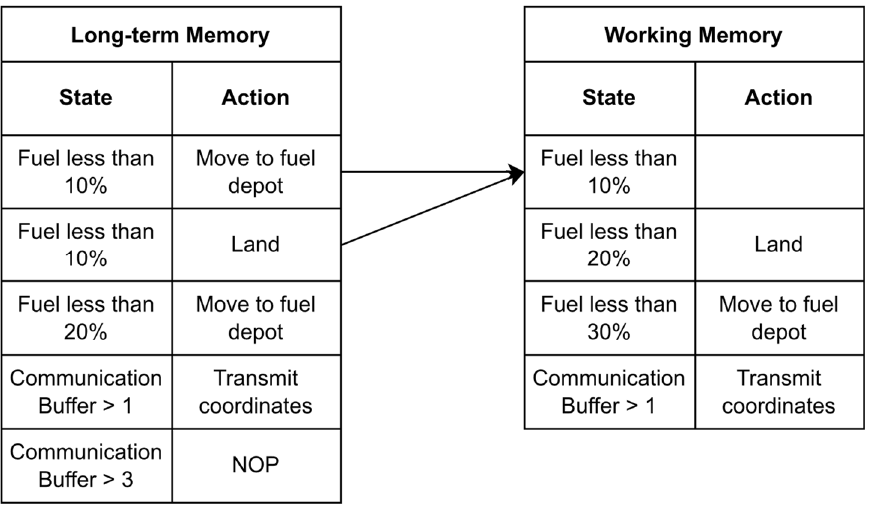
Figure 5. In complementary layered learning, the long-term memory seeds the working memory in the terminal layer. In this case, the working memory’s “Fuel less than 10%” state will be copied from the long-term memory’s matching state.